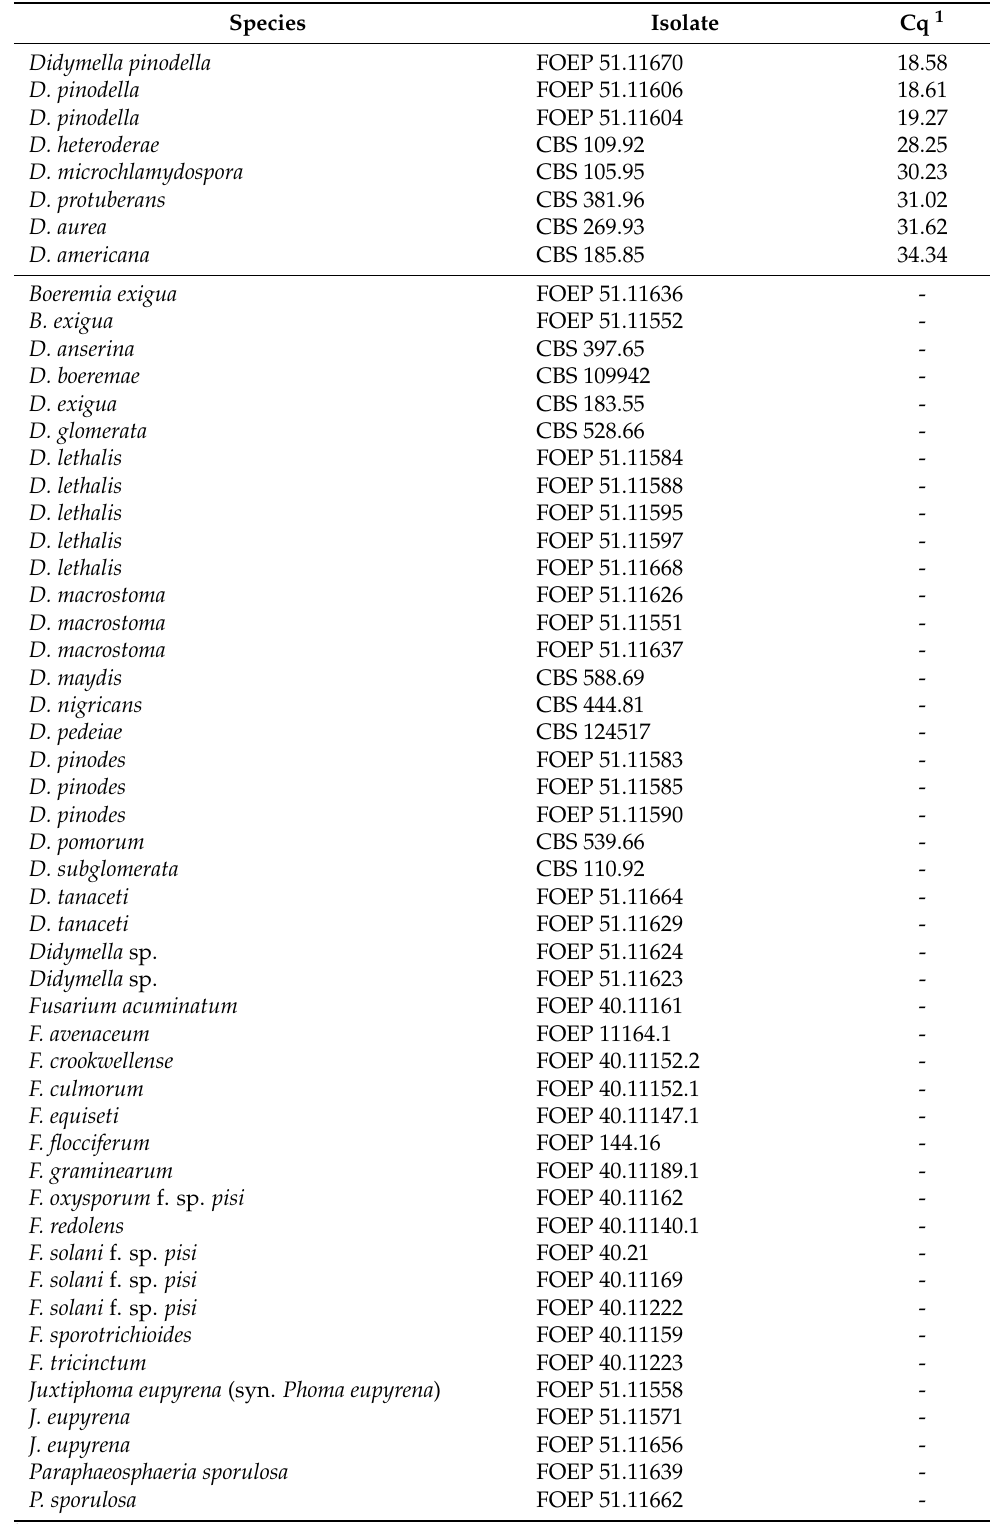
Table 4. Quantification cycle (Cq) values of DpinodellaTef primer and probe set tested against pure fungal DNA extracts in a 54 isolate/35 species validation